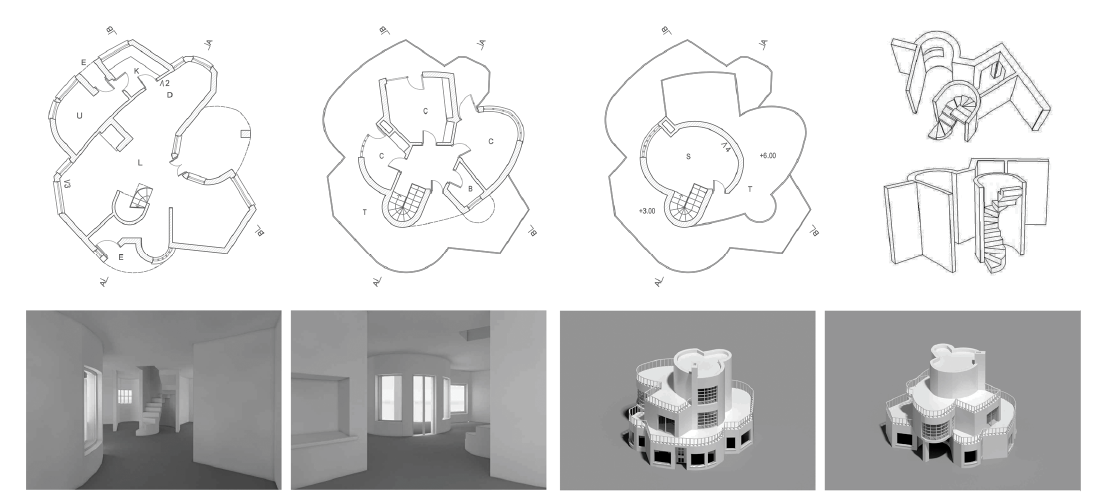
Figure 10. House 9. Plans, schemes, axonometric views, perspectives (C. Gelardi).